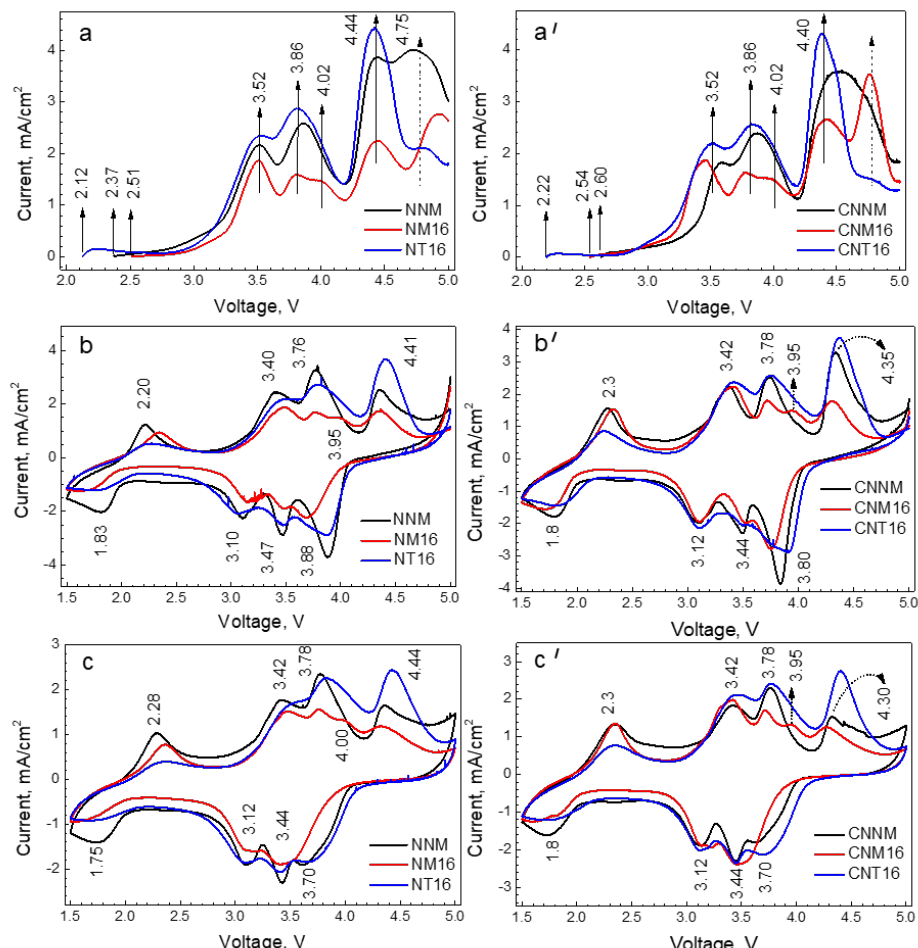
Figure 4. CV curves of metal-substituted oxides ( a – c ) and their CeO 2 -treated analogues ( a’ – c’ ) in sodium-ion cells: (i) first anodic scan ( a , a’ ); (ii) the corresponding cathodic scan and next anodic scan ( b , b’ ); (iii) CV curves after five cycle ( c , c’ ). The scan rate is 1 mV/s.